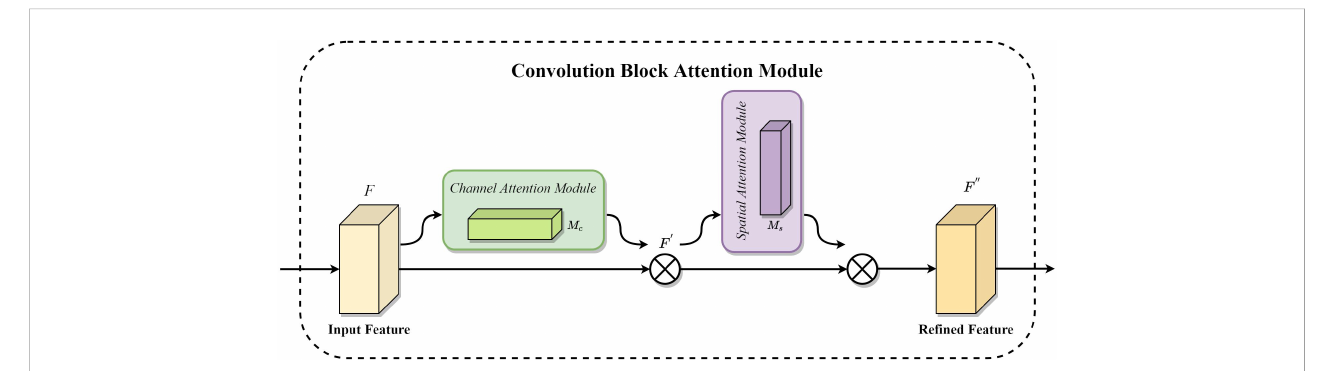
FIGURE 5 Convolution Block Attention Module.